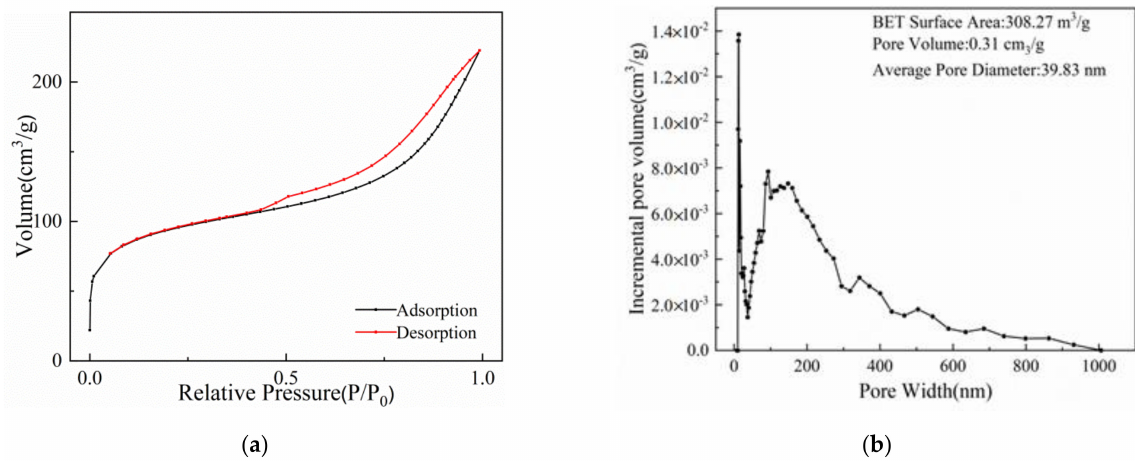
Figure 10. ( a ) N 2 adsorption–desorption isothermal curve of T-BSA; ( b ) pore distribution of